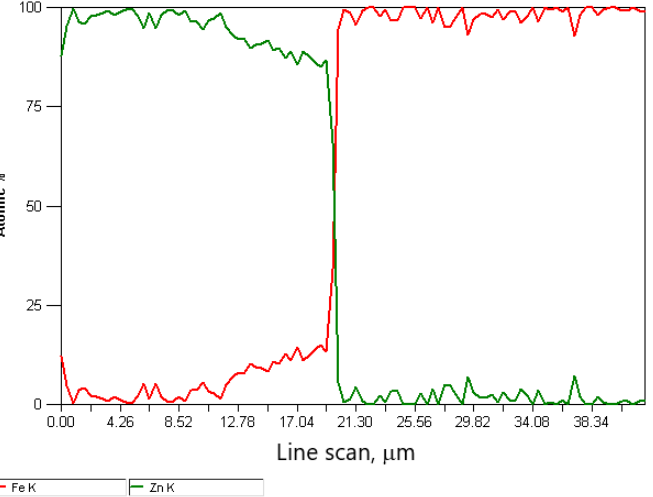
Figure 7. The EDS spectral X-ray analysis in the micro-areas of the coating on the cross-section of the galvanized K20 wire.